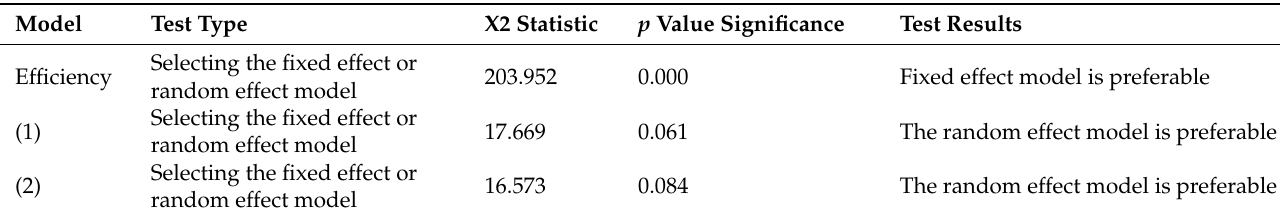
Table 6. Hausman test results.